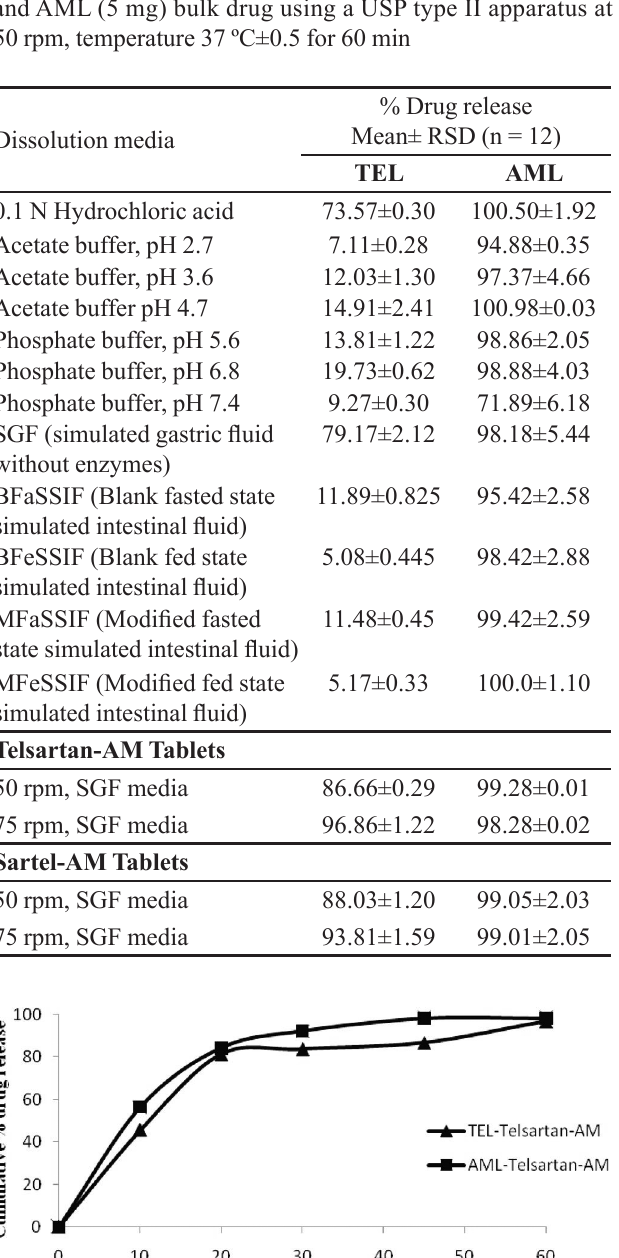
TABLE I - Screening study results for dissolution of TEL (40 mg) and AML (5 mg) bulk drug using a USP type II apparatus at